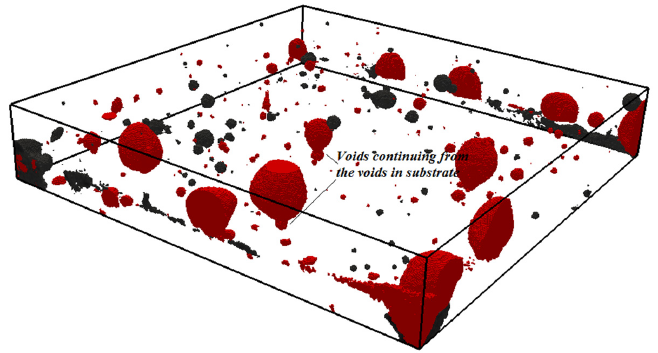
Figure 15. Void content in the repair system close to the interface, w/c = 0.3, WS, S2 (3mm thickness): ( a ) original structure (whole GSV range); and ( b ) thresholded voids (chosen GSV range).